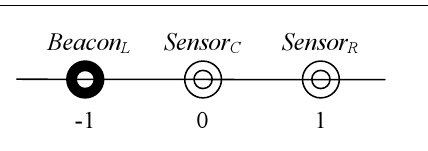
Figure 3. A scenario for a beacon node and two sensor nodes.